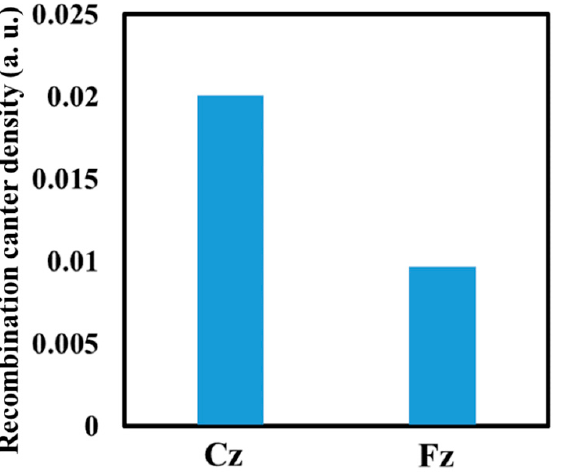
Figure 1. The recombination center densities in Cz-Si and Fz-Si estimated with minority carrier life- time.